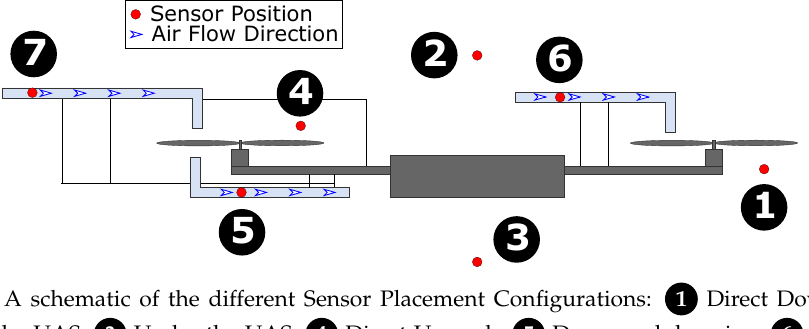
Figure 2. A schematic of the different Sensor Placement Configurations: 1 Direct Downwash, 2 Over the UAS, 3 Under the UAS, 4 Direct Upwash, 5 Downwash housing, 6 Upwash Housing with Inlet Pointed Inside, and 7 Upwash Housing with Inlet Pointed